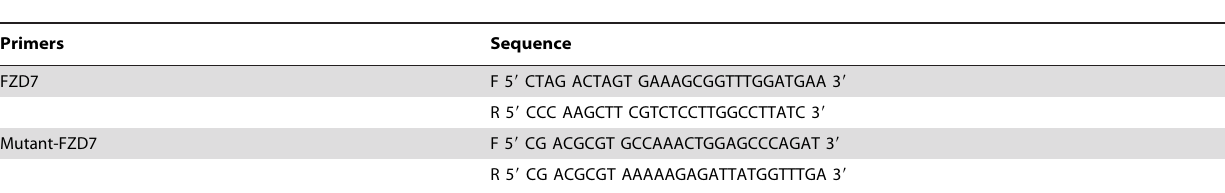
Table 2. Primers for the 3 9 UTR of FZD7 and Mutant-FZD7.